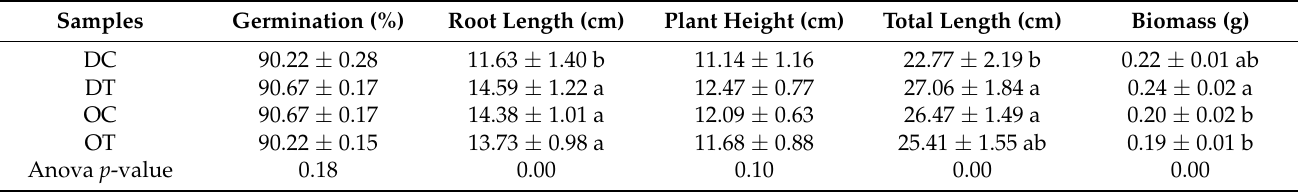
Table 5. Seed germination rate and plant growth